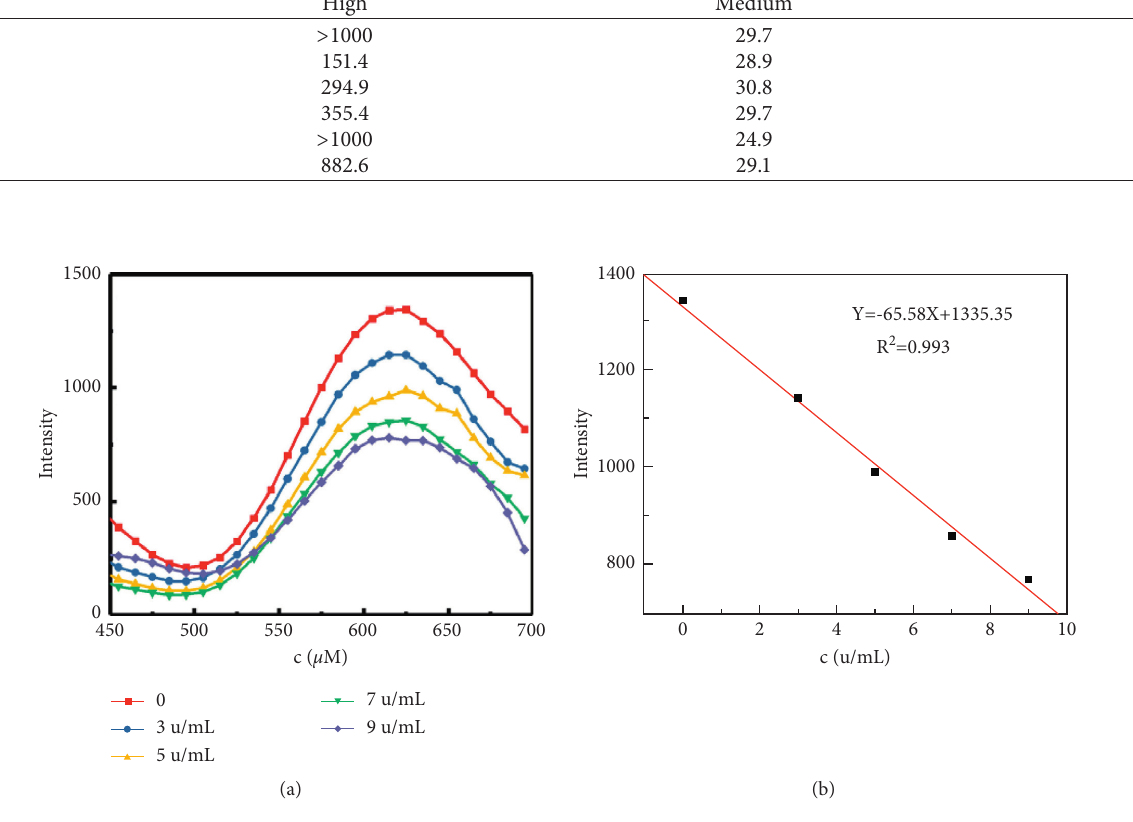
Figure 6: Fluorescence spectra (a) and normalized fluorescence intensity at 610 nm (b) with the increases in concentrations of CA125 from 0 to 9 u/mL; the excitation wavelength was